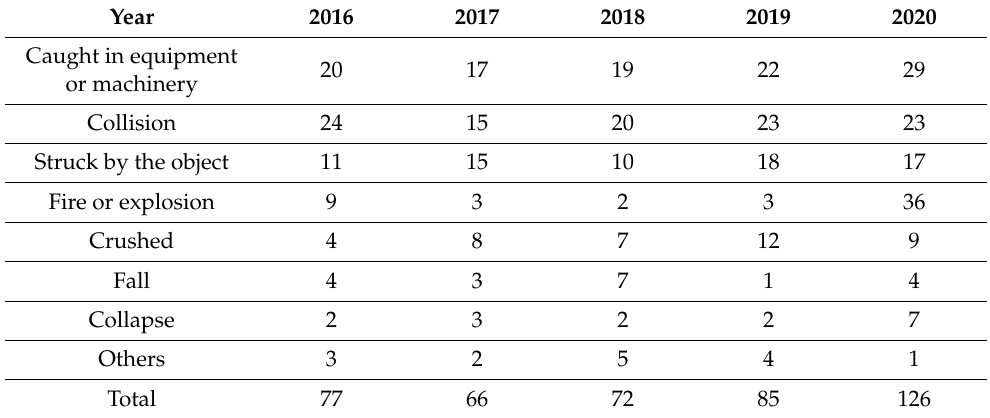
Table 4. Fatalities based on the accident type caused by multiple processes in the workplace (person).